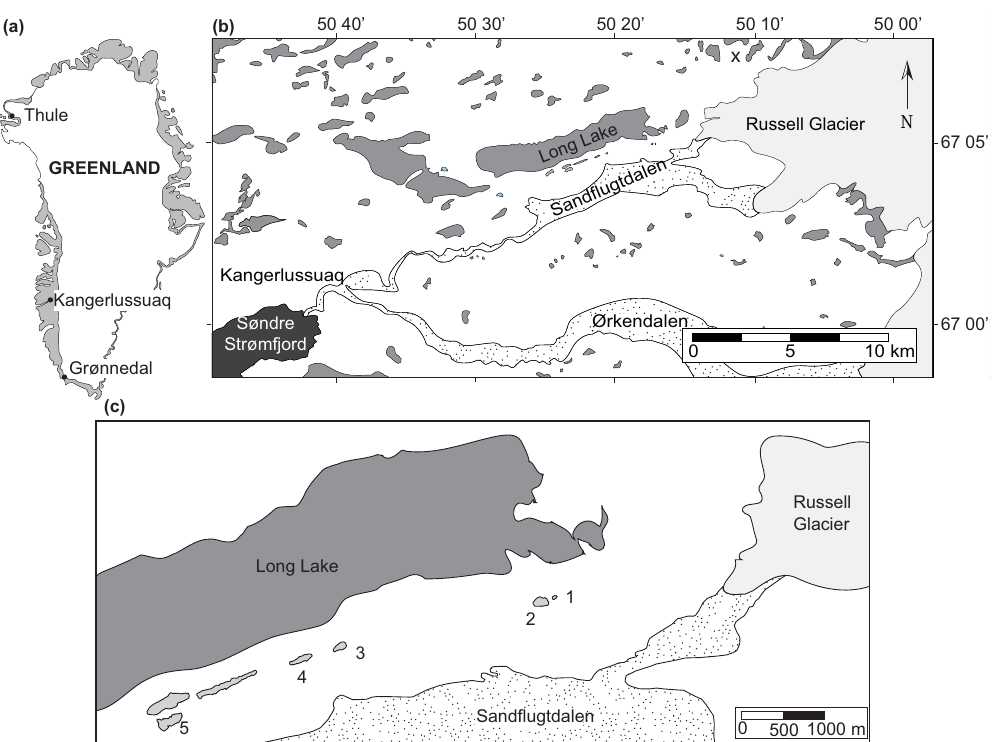
Figure 2. (a) Greenland, showing Kangerlussuaq. (b) Regional map of Kangerlussuaq and the inland ice margin, including Sandflugtdalen and Ørkendalen, which are two major proglacial valley sandur systems. X marks the location of the Geological Survey of Denmark and Greenland (GEUS) weather station. (c) Study area map of lakes relative to the Russell Glacier, Long Lake, and Sandflugtdalen sandur. (1) EVV Upper lake, (2) EVV Lower lake, (3) Teardrop lake, (4) Potentilla lake, and (5) South Twin lake. Figure is modified from Cadieux et al.